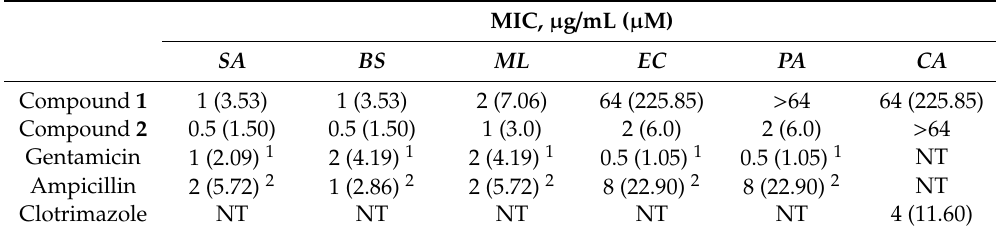
Clotrimazole NT NT NT NT NT 4